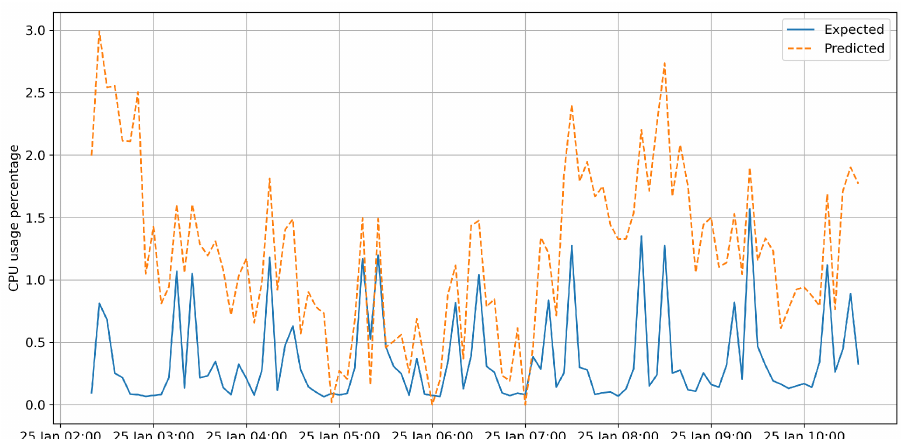
Figure 8. Sample validation predictions—ARIMA.